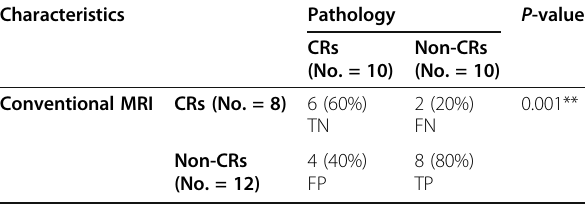
Table 2 Conventional MRI versus pathology in the studied